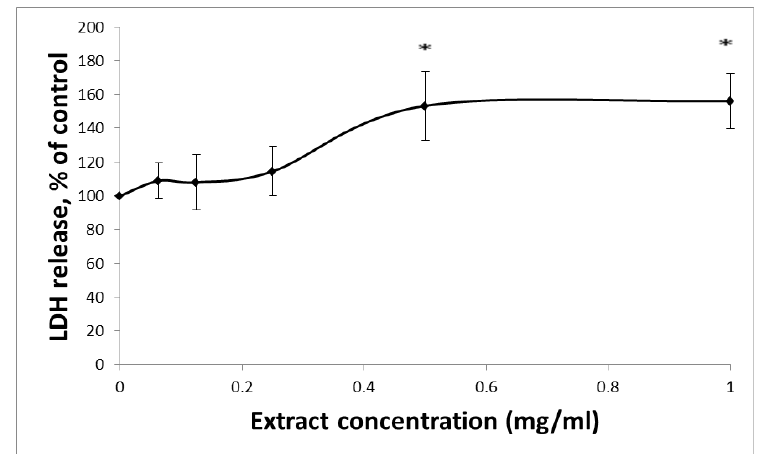
Figure 2. LDH leakage from HCT-116 cells after 24 h incubation with varying concentrations of HTE. The leakage of LDH into the extracellular medium is measured. The absorbance was measured